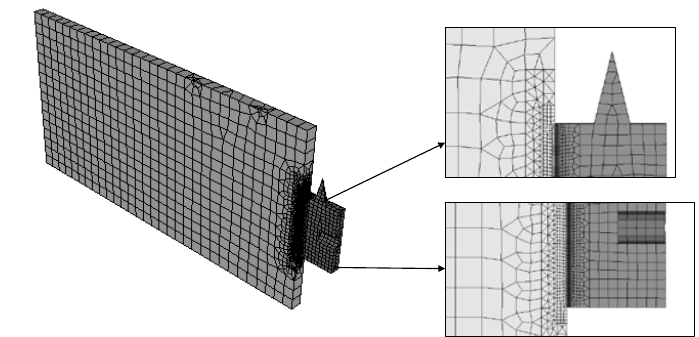
Fig. 11 Mesh of the three-dimensional model in DIANA FEA